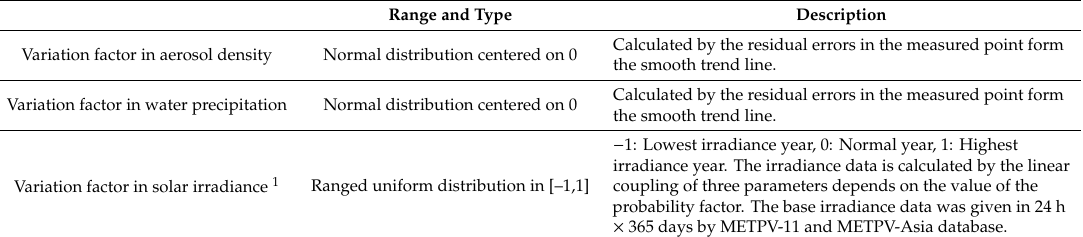
Table 2. List of the probability parameters for modeling variation of annual performance (independent parent parameters).